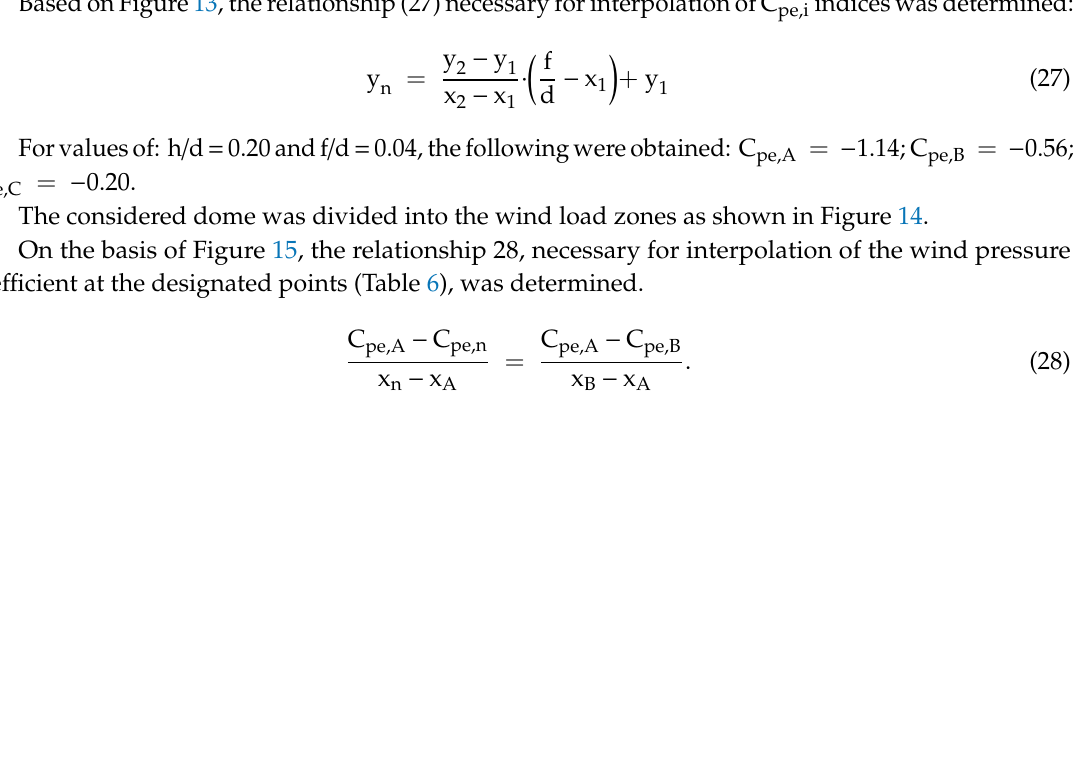
Figure 14. Wind zones of the dome.